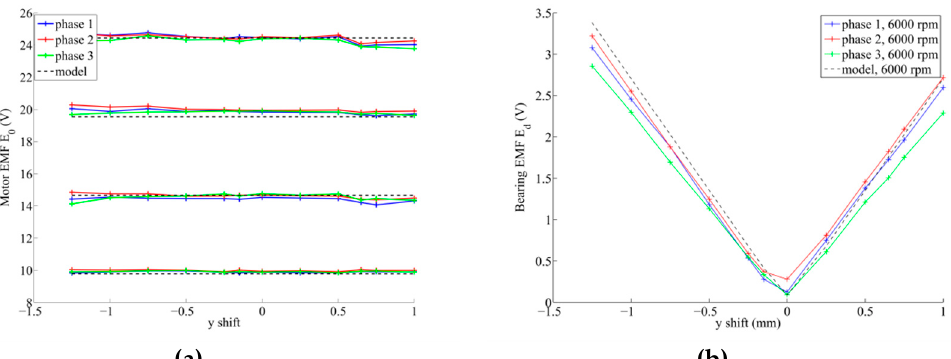
Figure 15. Experimental and model predictions for the three phases ( a ) of the motor electromotive force E 0 at spin speeds of 2400, 3600, 4800, and 6000 rpm and ( b ) of the bearing electromotive force E d , at a spin speed of 6000 rpm as a function of the rotor position in the y-axis.